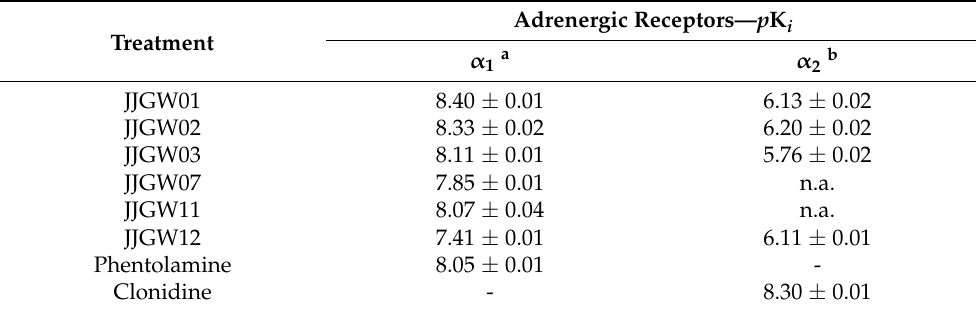
Table 1. The affinity of the tested compounds for α 1 - and α 2 -adrenergic receptors.